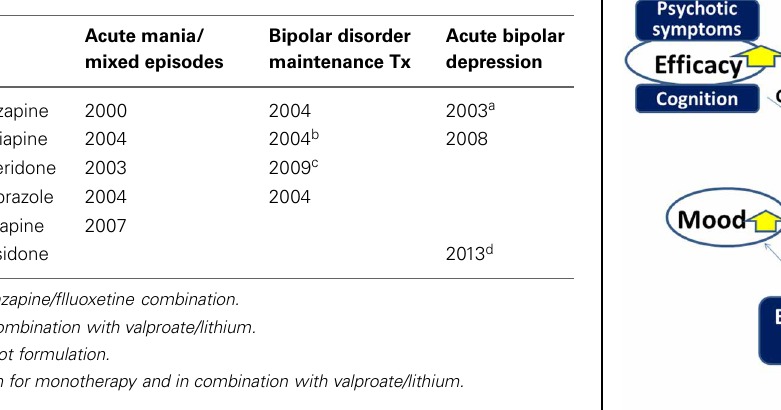
Table 1 | Year of approval by FDA of AAPDs for bipolar disorder.